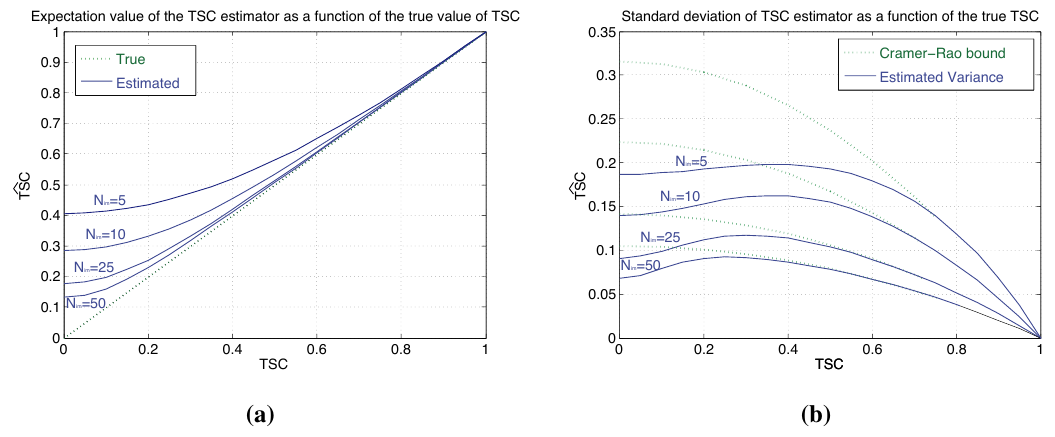
Figure 6. ( a ) Expectation value and ( b ) standard deviation of the TSC estimation as a function of its “true” value, for different numbers of images.